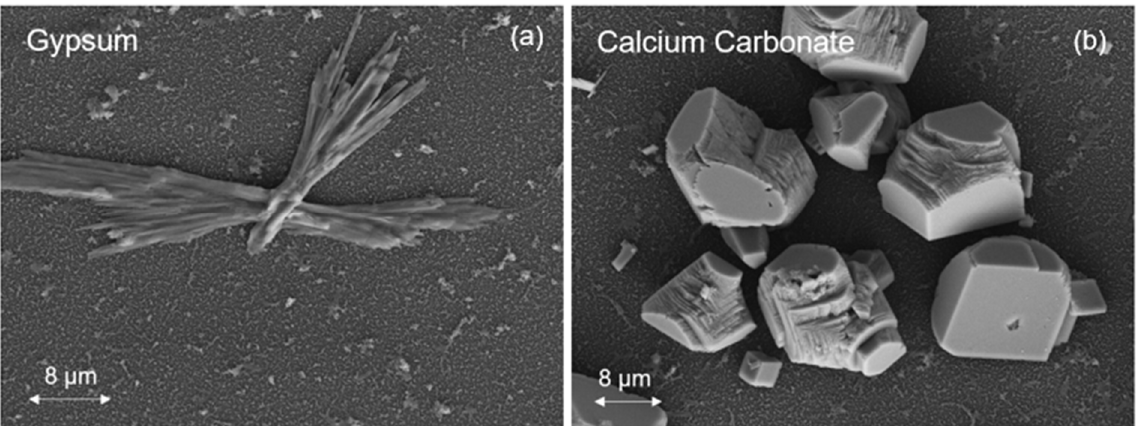
Figure 2. SEM top-view images of the gypsum ( a ) and calcite ( b ) scale on the SNS-PAA-PA membrane surface (at the end of 24 h scaling tests). (Saturation indices at the membrane surface: SI g,m = 1.7 and SI c.m = 10.6.).